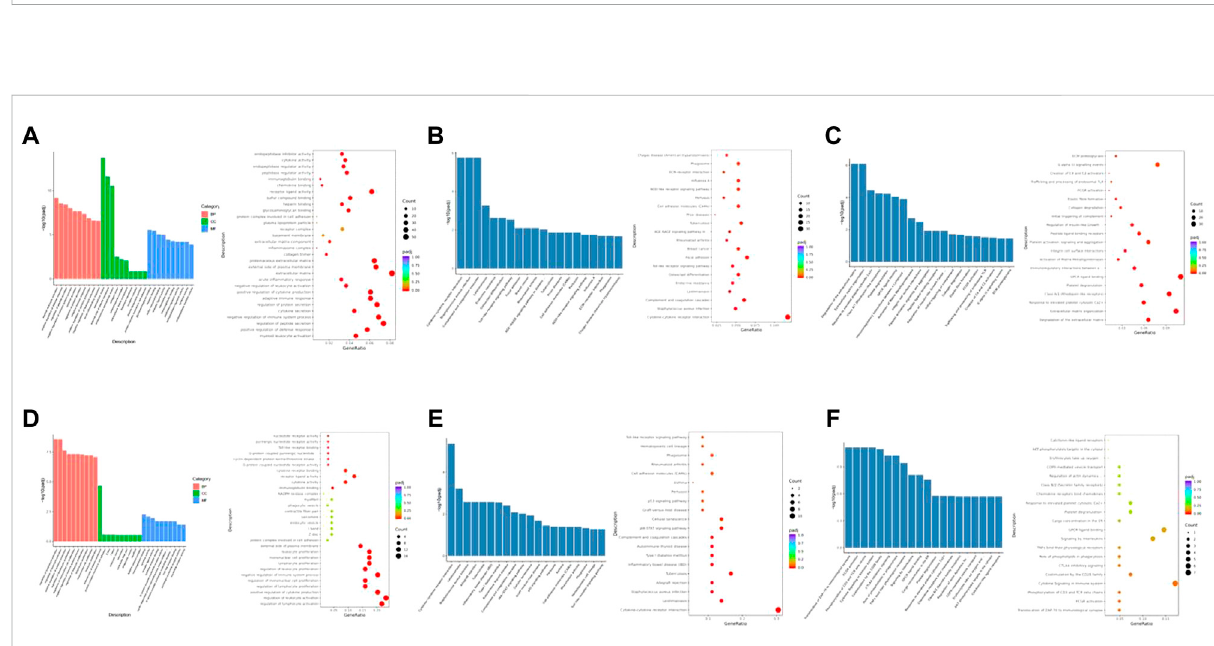
FIGURE 5 Enrichment analyses of differentially expressed genes at 6 months after radiation. (A) GO function enrichment analysis, (B) KEGG pathway analysis, and (C) Reactome enrichment analysis of differentially expressed mRNAs in the low-dose irradiation group after 6 months (D) GO function enrichmentanalysis, (E) KEGGpathwayanalysis,and (F) ReactomeenrichmentanalysisofdifferentiallyexpressedmRNAsinthehigh-doseirradiation group after 6 months. BP, Biological Process; CC, Cellular Component; MF, Molecular